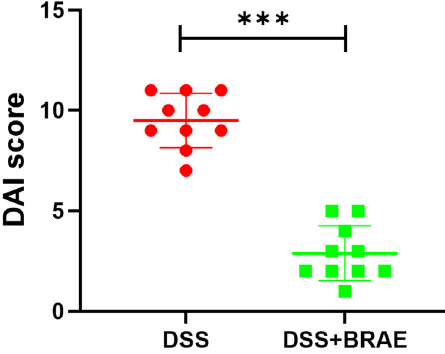
Figure 4: DAI. Data represent mean ± SD ( n = 10 ) . *** P <